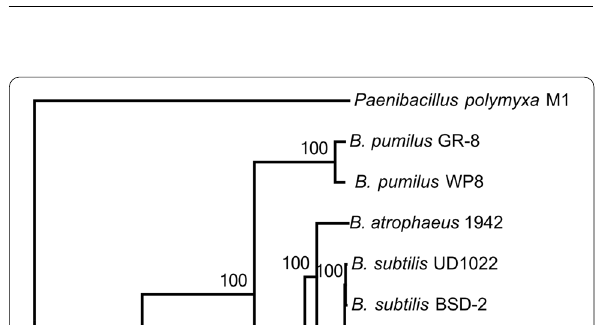
Figure S2). This was confirmed by the pan-genome analy- sis carried out among four B. velezensis strains. Genome- wide comparisons of orthologous clusters between PG12 and closely related B. velezensis strains indicated